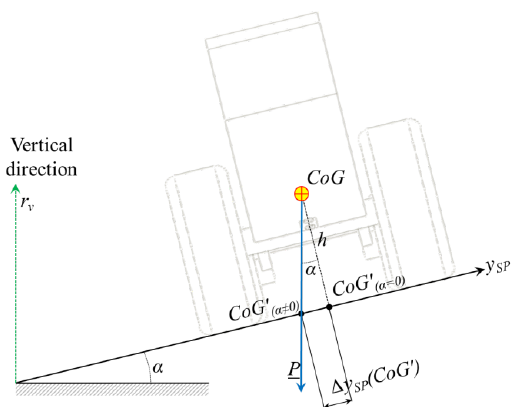
Figure 9. Shift of CoG′ downstream as a consequence of the inclination of the support plane; in the represented case the transversal axis of the tractor ( y t ) is parallel and opposite to y SP .